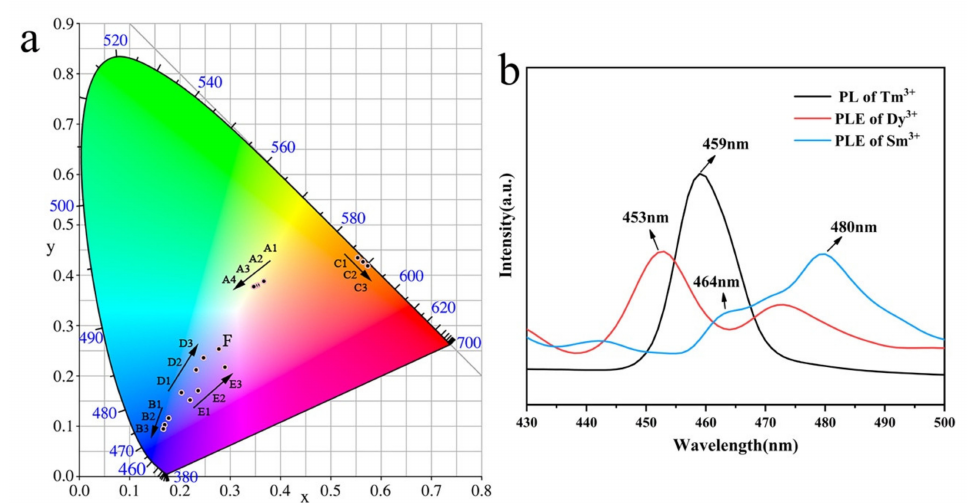
Figure 3. ( a ) The CIE chromaticity diagram of NGT: x %Tm 3 + , NGT: y %Dy 3 + , NGT: z %Sm 3 + , NGT: 3%Tm 3 + / m %Dy 3 + , NGT: 3%Tm 3 + / n %Sm 3 + , and NGT: 3%Tm 3 + / 5%Dy 3 + / 2%Sm 3 + phosphors. Points A1–A4 represent NGT: y %Dy 3 + ( y = 1, 3, 7, 9) phosphors, points B1–B3 represent NGT: x %Tm 3 + ( x = 1, 2, 3) phosphors, points C1–C3 represent NGT: z %Sm 3 + ( z = 1, 2, 3) phosphors, points D1–D3 represent NGT: 3%Tm 3 + / m %Dy 3 + ( m = 1, 2, 3) phosphors, points E1–E3 represent NGT: 3%Tm 3 + / n %Sm 3 + ( n = 1, 2, 4) phosphors, and point F represents the NGT: 3%Tm 3 + / 5%Dy 3 + / 2%Sm 3 + phosphors. ( b ) Overlap between the photoluminescence (PL) emission spectrum of the NGT: Tm 3 + phosphor and the PL excitation spectra of the NGT: Dy 3 + and NGT: Sm 3 + .